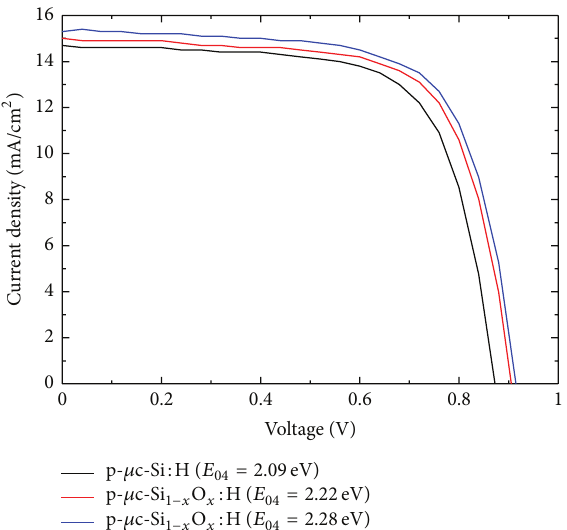
Figure 9: I-V characteristics of a-Si:H solar cells with p- 𝜇 c-Si:H and p- 𝜇 c-Si 1−𝑥 O 𝑥 :H layers.